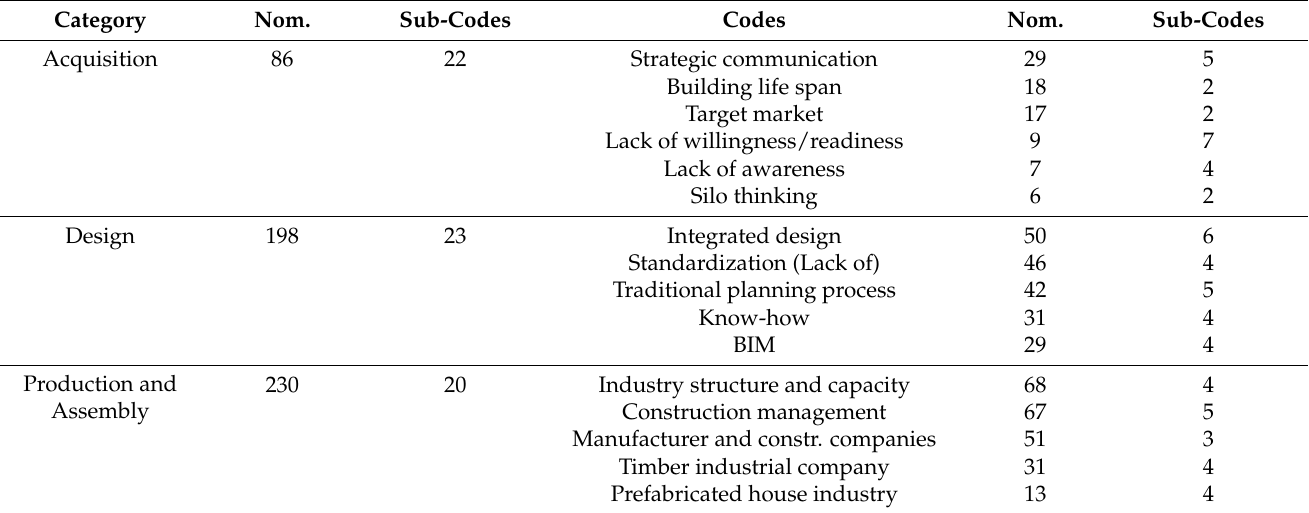
Table 3. Summary of results according to the frequency of nominations.